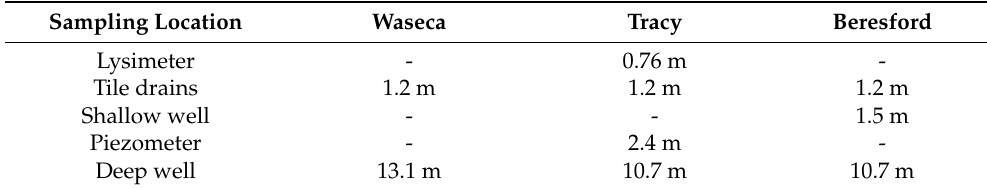
Figure 2. Sampling locations at each site. ( a ) Beresford, SD site sampling locations. Locations within the research farm is shown in the inset map on a smaller scale; ( b ) Tracy, MN site sampling locations. Locations within the research farm is shown in the inset map on a smaller scale; ( c ) Waseca, MN site sampling locations. Table 1. Subsurface sampling depth at each site (from shallow to deep).